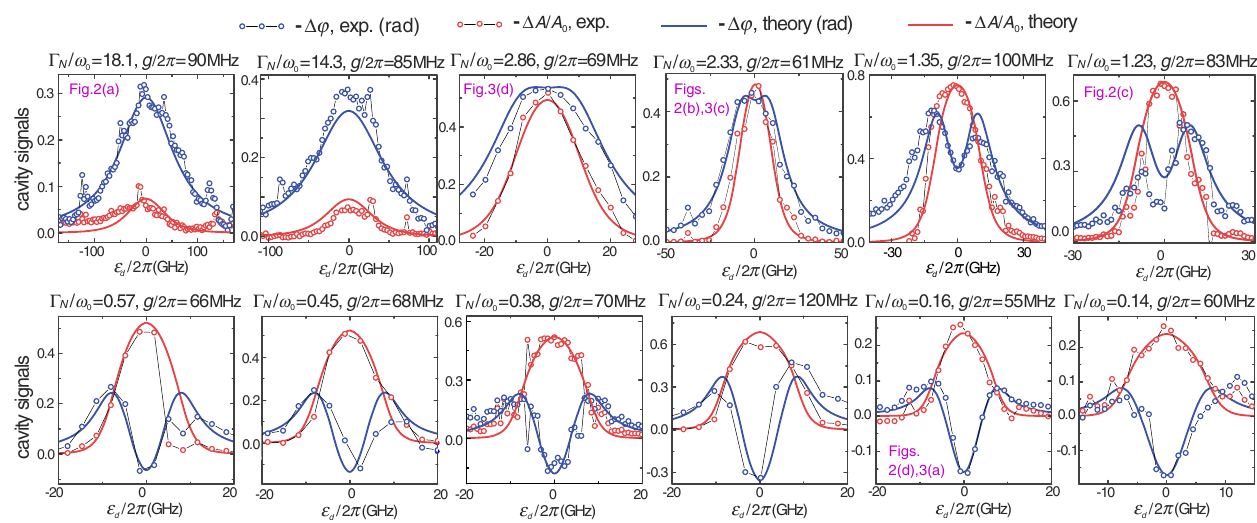
0 and different dot orbitals with decreasing tunnel rates for V d b ¼